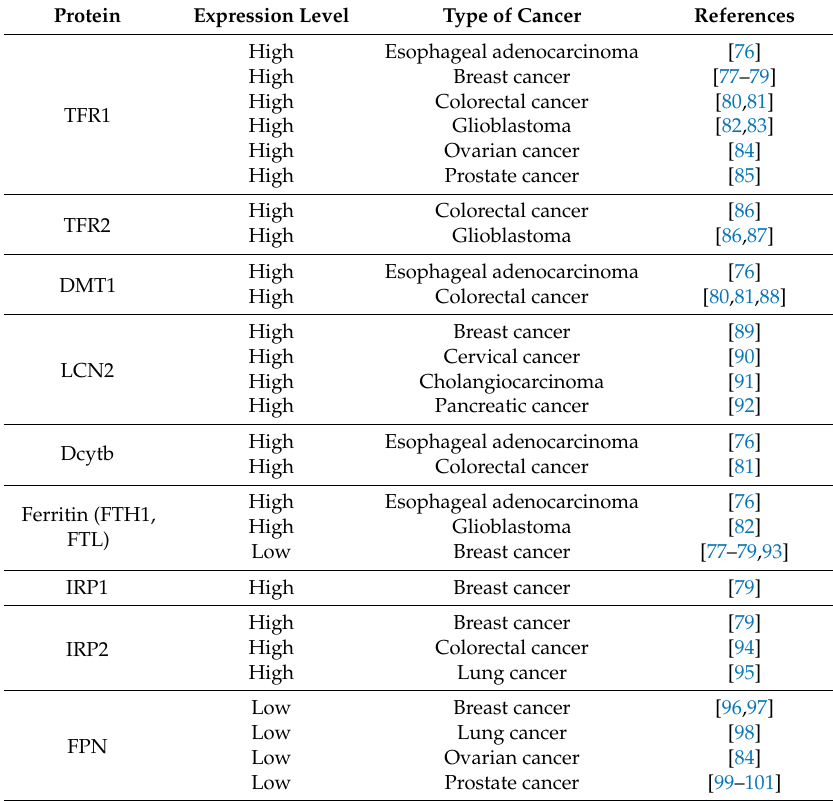
Table 1. Expression level iron metabolism-related proteins in cancer